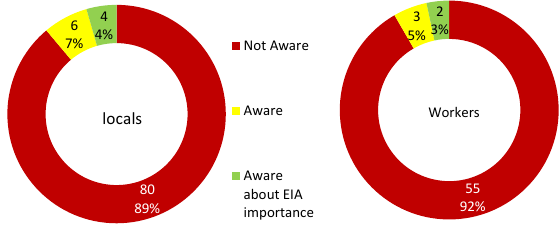
Figure 10: No. od people concerned about deforestation w.r.t. local vs